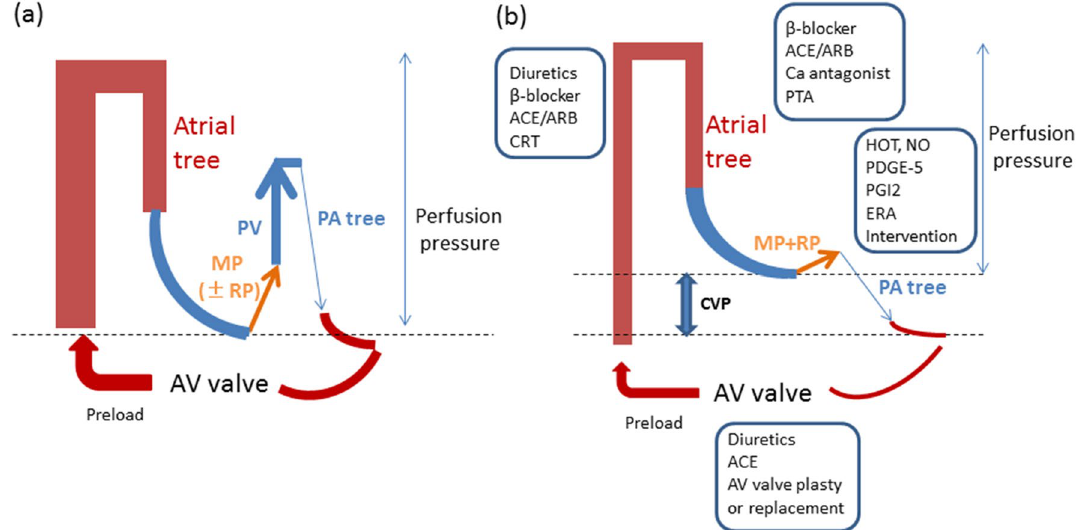
Figure 1. Hemodynamic changes after the Fontan procedure and treatment thereof. Central venous pressure frequently increases after Fontan surgery ( b ) compared to normal ( a ). ACE, angiotensin-converting enzyme; ARB, angiotensin receptor blocker; AV, atrioventricular; Ca, calcium; CRT, cardiac resynchronization therapy; CVP, central venous pressure; ERA, endothelin receptor blocker; HOT, home oxygen therapy; MP, muscle pump; NO, nitric oxide; PA, pulmonary artery; PV, pulmonary ventricle; PDGE-5, phosphodiesterase 5 inhibitor; PGI2, prostaglandin I2; PTA, percutaneous transluminal angioplasty; RP, PA